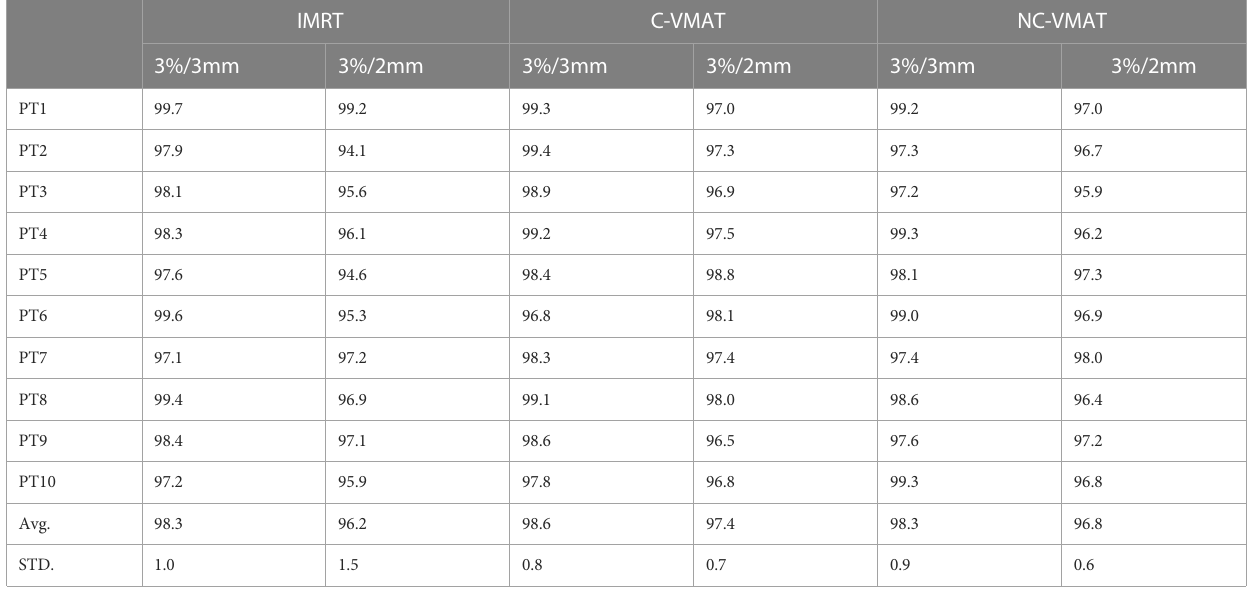
TABLE 8 Quality